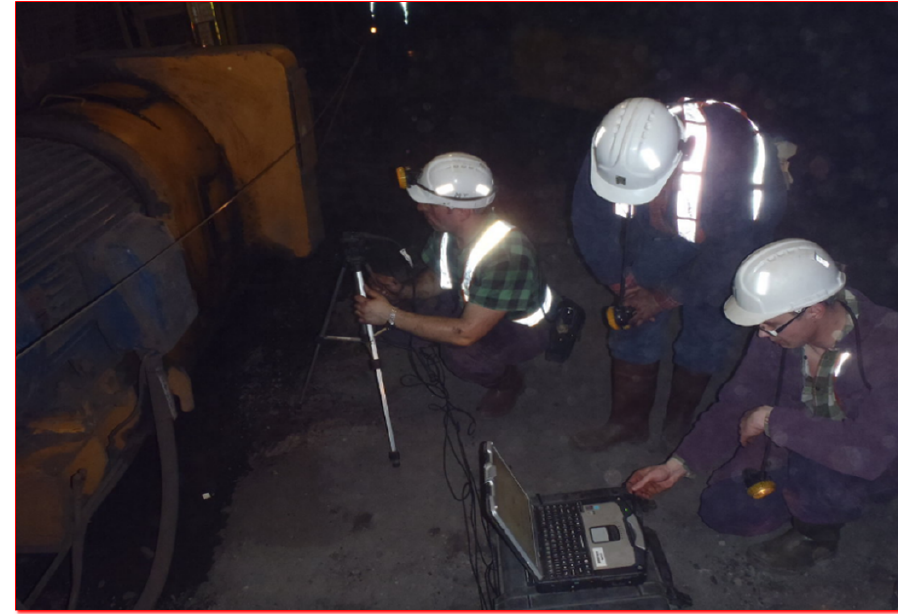
Figure 4. Intervention of the inspection